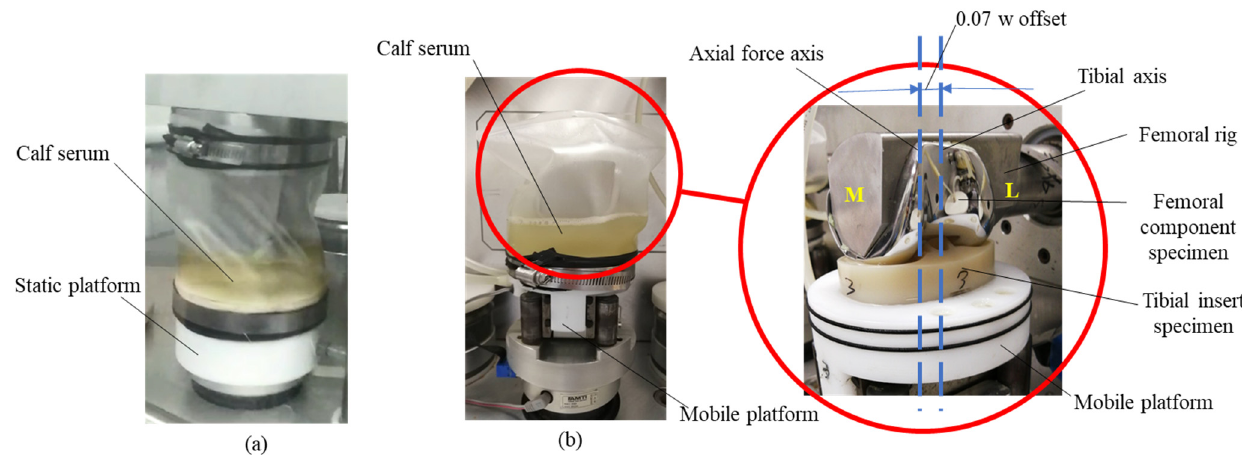
Figure 1. Setup of the wear test with the AMTI knee simulator. ( a ) Setup of the control specimen in the knee simulator. The control specimen was immersed in calf serum (20 g/L) throughout the wear test and subject to the same time-varying axial force as the test specimen, intending to determine the amount of mass change due to fluid transfer. ( b ) Setup of the test specimen in the knee simulator. The test specimen was immersed in calf serum (20 g/L) throughout the wear test and subject to a loading condition including axial force, anterior-posterior (AP) force, rotation torque, and flexion angle, in order to test the implant wear (M: Medial; L: Lateral).